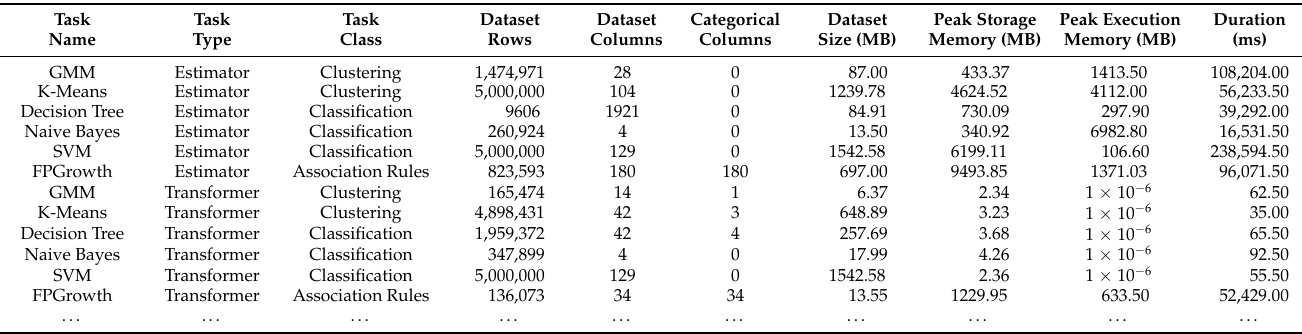
Table 3. A sample of the training